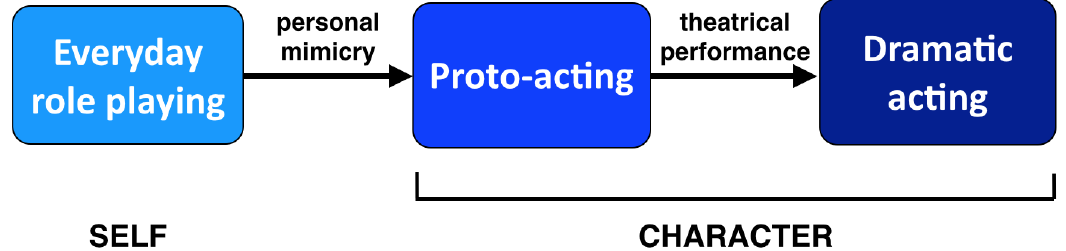
Figure 1. Proto-acting as an intermediate function between everyday role playing and dramatic acting. Whereas everyday role playing involves variants of the self, both proto-acting and dramatic acting involve character portrayal.